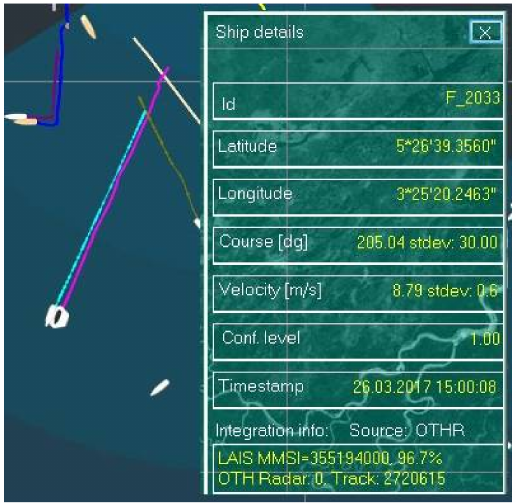
Figure 4. Resolving a “clear situation”—vessel is sailing in a straight line (light purple trace MRTF, light blue trace